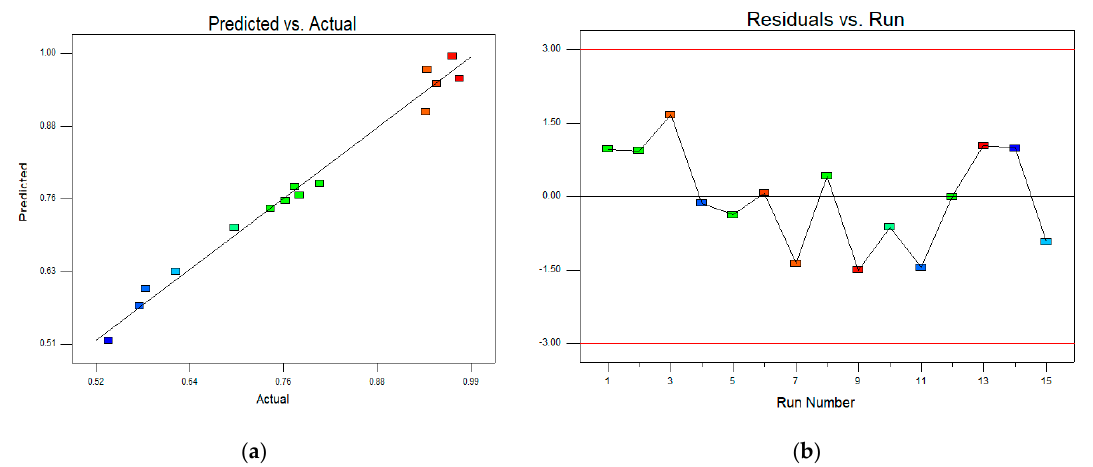
Figure 2. Plots depicting ( a ) actual responses versus predicted responses and ( b ) normalized residuals of experimental attempts.